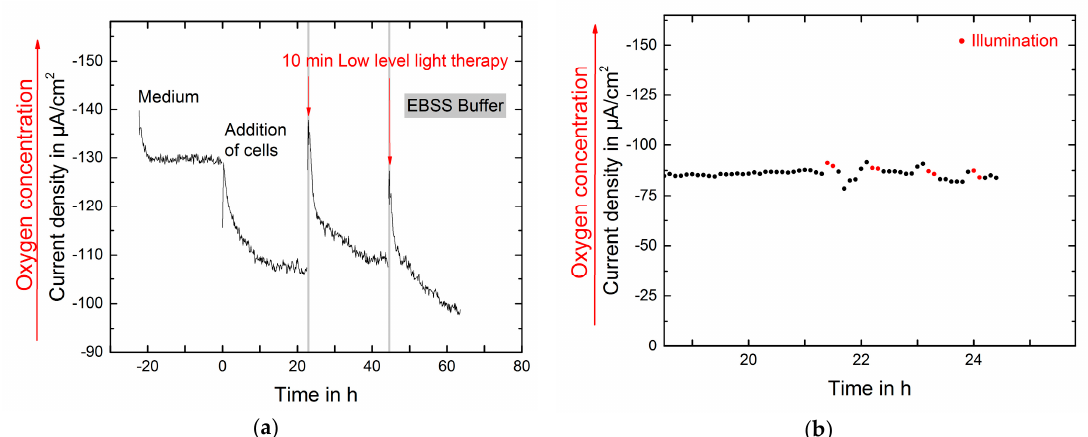
Figure 4. ( a ) Monitoring of the respiration of NIH-3T3 cells over three days. On two consecutive days low-level light therapy was applied and in consequence the oxygen concentration decreased significantly; ( b ) Oxygen measured in EBSS Buffer at room temperature: after 21 h four illuminations à 10 min take